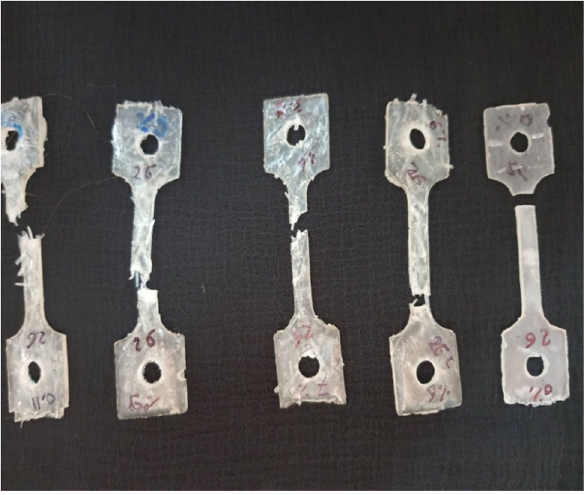
Figure 12: Samples that failed at